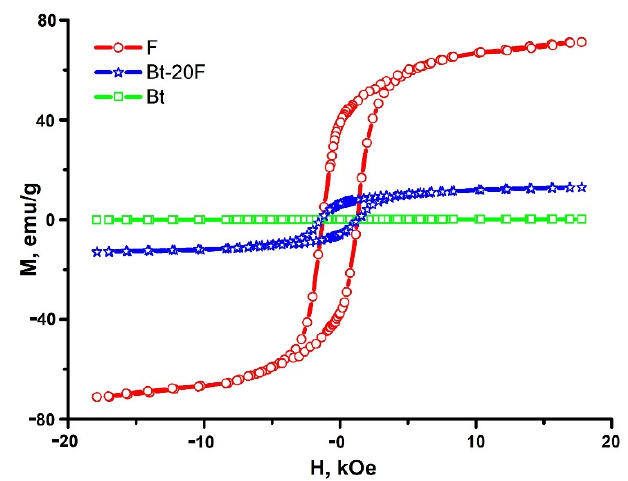
Figure 6. Magnetic properties of bentonite (Bt), cobalt ferrite (F) and composite (Bt-20F). The samples F and Bt-20F demonstrated the dependence of magnetization on the field, which is typical for hard magnetic materials [57,70]. The coercive force for the sam- ple F was 1290 Oe and 1360 Oe for the sample Bt-20F. The saturation magnetization of F was 71.1 emu/g. For the Bt-20F composite, the saturation magnetization was 12.9 emu/g. The values of the coercive force and saturation magnetization of the Bt-20F composite sat- isfied the solution of the problem of its extraction from an aqueous suspension under the action of an external magnetic field at ambient temperature. This allowed us to consider the proposed sorbent as magnetically sensitive and magnetically controllable.